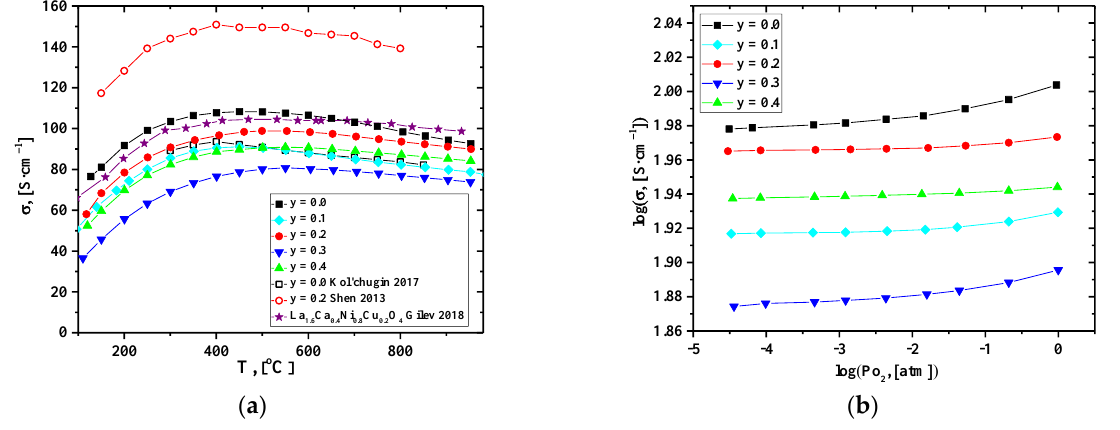
Figure 4. Dependencies of the total conductivity of the La 1.7 Ca 0.3 Ni 1 − y Cu y O 4+ δ ceramics on: ( a ) on temperature, and ( b ) on pO 2 [35,37].